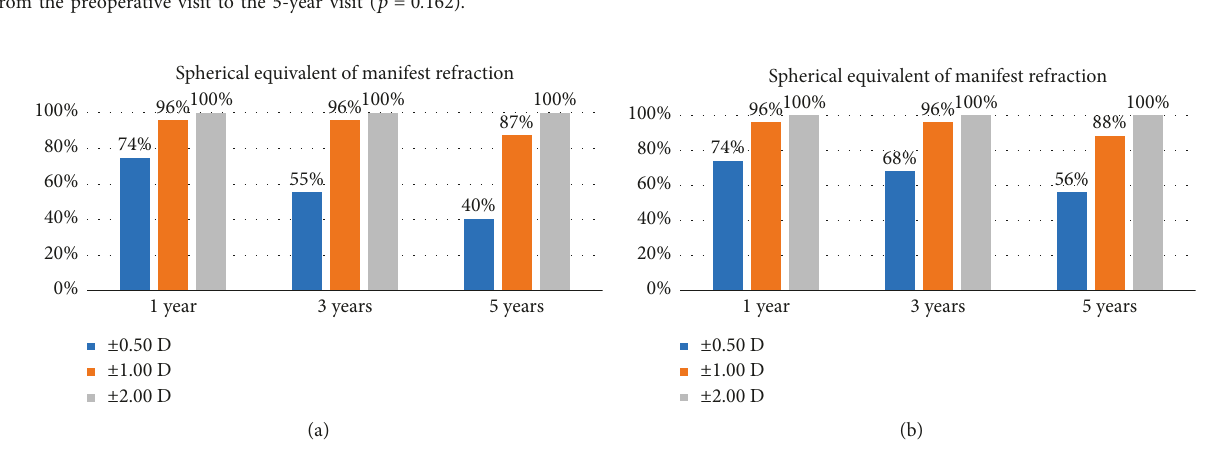
Figure 2: Spherical equivalent of mean manifest refraction in Verisyse (a) and Veriflex (b) groups.